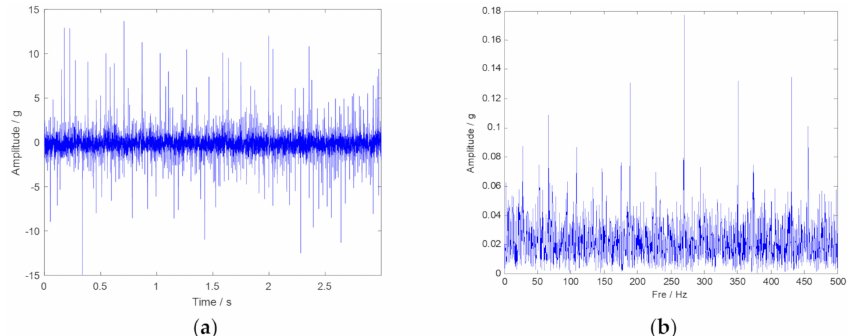
Figure 8. The time-domain and frequency-domain spectra of the original vibration signal. ( a ) Vibration signal shown in time-domain; ( b ) Vibration signal shown in frequency-domain.